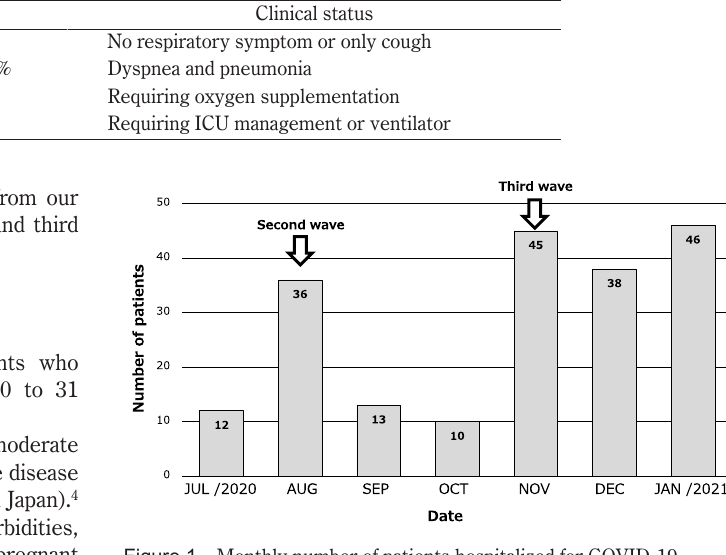
Figure 1 Monthly number of patients hospitalized for COVID-19. In July, there were 12 patients, but in August there were 36, which was the second wave. The number decreased to 13 in September and 10 patients in October, but increased rapidly to 45 patients in November, marking the third wave. In December there were 38 patients and in January there were 46 patients.